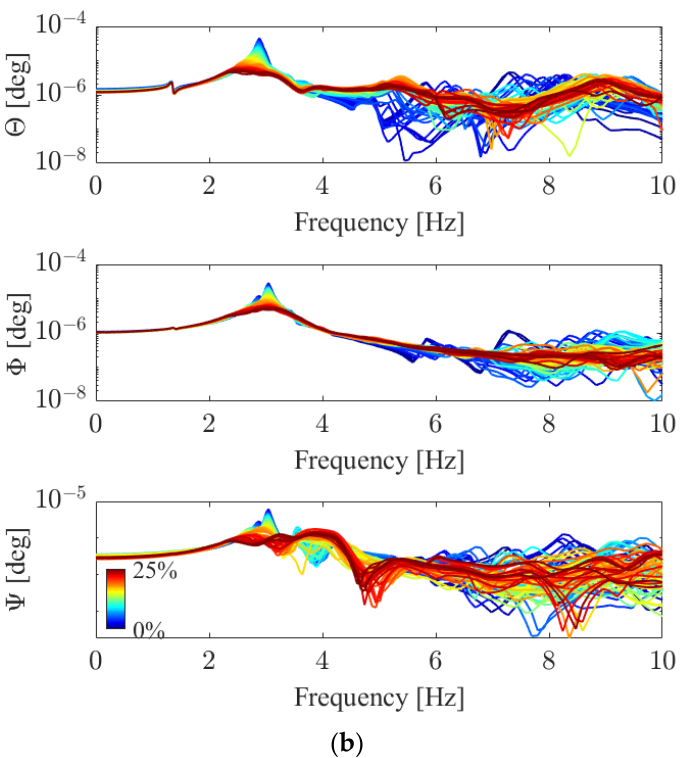
Figure 9. Pointing error minimization using the MTMD under Configuration 1 for the primary operational case modelled with the PSD. ( a ) Multi-objective Pareto front of all individuals analyzed, indicating the utopian point and the best individual. ( b ) Frequency response functions of the deviation angles for each respective direction, where the color bar indicated represents the percentage of mass inclusion in the antenna.